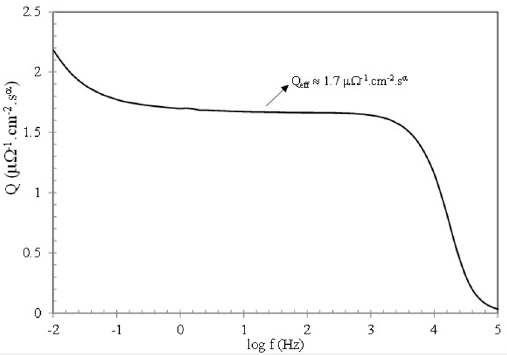
, following the procedure described Figure 8. Determination of Q eff by Orazem et al. 31 . materials 41,42 . The n-type behavior is associated with electron donors and is related with the presence of oxygen vacancies and cation interstitials whereas the p-type behavior is associated with electron acceptors and is related to the presence of cation vacancies 43 . The Mott-Schottky relationships can be used to determine the type of semiconducting behavior and also the doping densities, according to equations (5) and (6) which are valid for n-type and p-type behaviors, respectively 44,45 . In these equations N and N are the donor D A and acceptor densities, e is the elementary charge, k is the Boltzmann constant, T is the absolute temperature, C is the capacitance, E is the applied potential, E is the flat band FB potential, ε is the dielectric constant of the passive film (15.6 for stainless steels) and ε is the vacuum permittivity 0 (8.85.10 -14 F.cm -1 ). The Mott-Schottky plot is obtained by plotting 1/C 2 against E. A linear relationship with positive slope denotes the n-type behavior whereas a negative slope accounts for the p-type behavior 46,47